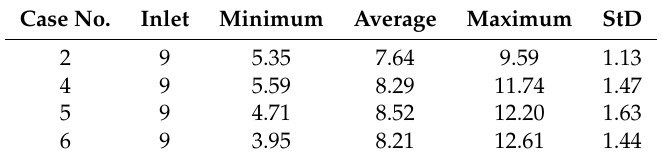
Figure 9. Variation of V N respecting the blade azimuth angle with dynamic inlet flow. ( a ) Case 4 (9m/s, 0.5Hz). ( b ) Case 5 (9m/s, 1.0Hz). ( c ) Case 6 (9m/s, 0.5Hz + 1.0Hz). Table 4. Nacelle wind speed with the same averaged inlet wind speed (m/s). Case No.